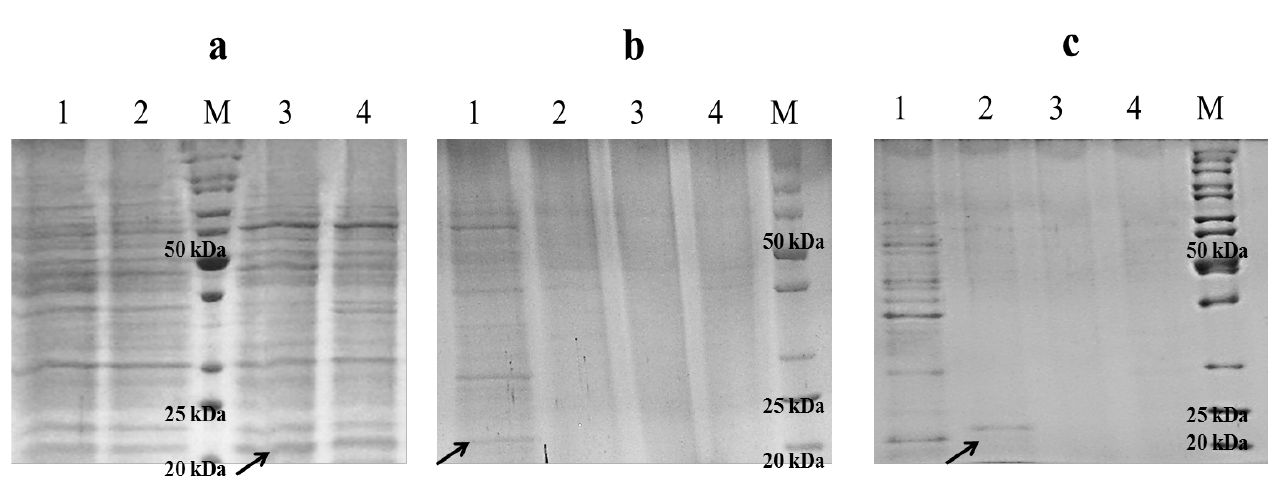
FIGURE 4 - SDS-PAGE analysis of INF-β-1a expression at different culture coditions for the supernatant of recombinant 11 after 72 h fermentation. a) Optimization of inducer concentrations; Lane 1-4: final concentration of methanol 0.5, 1, 2 and 3 %; M: Protein markers (kDa). b) Optimization of temperature. Lane 1-3: 20, 25 and 30°C; lane 4; the supernatant of recombinant culture before induction as a negative control; M: Protein markers (kDa). c) Optimization of pH. Lane 1-3: pH 8.0, 7.0 and 6.0; non-recombinant P. pastoris strain GS115 as a negative control; M: Protein markers (kDa). The expressed protein was indicated by the